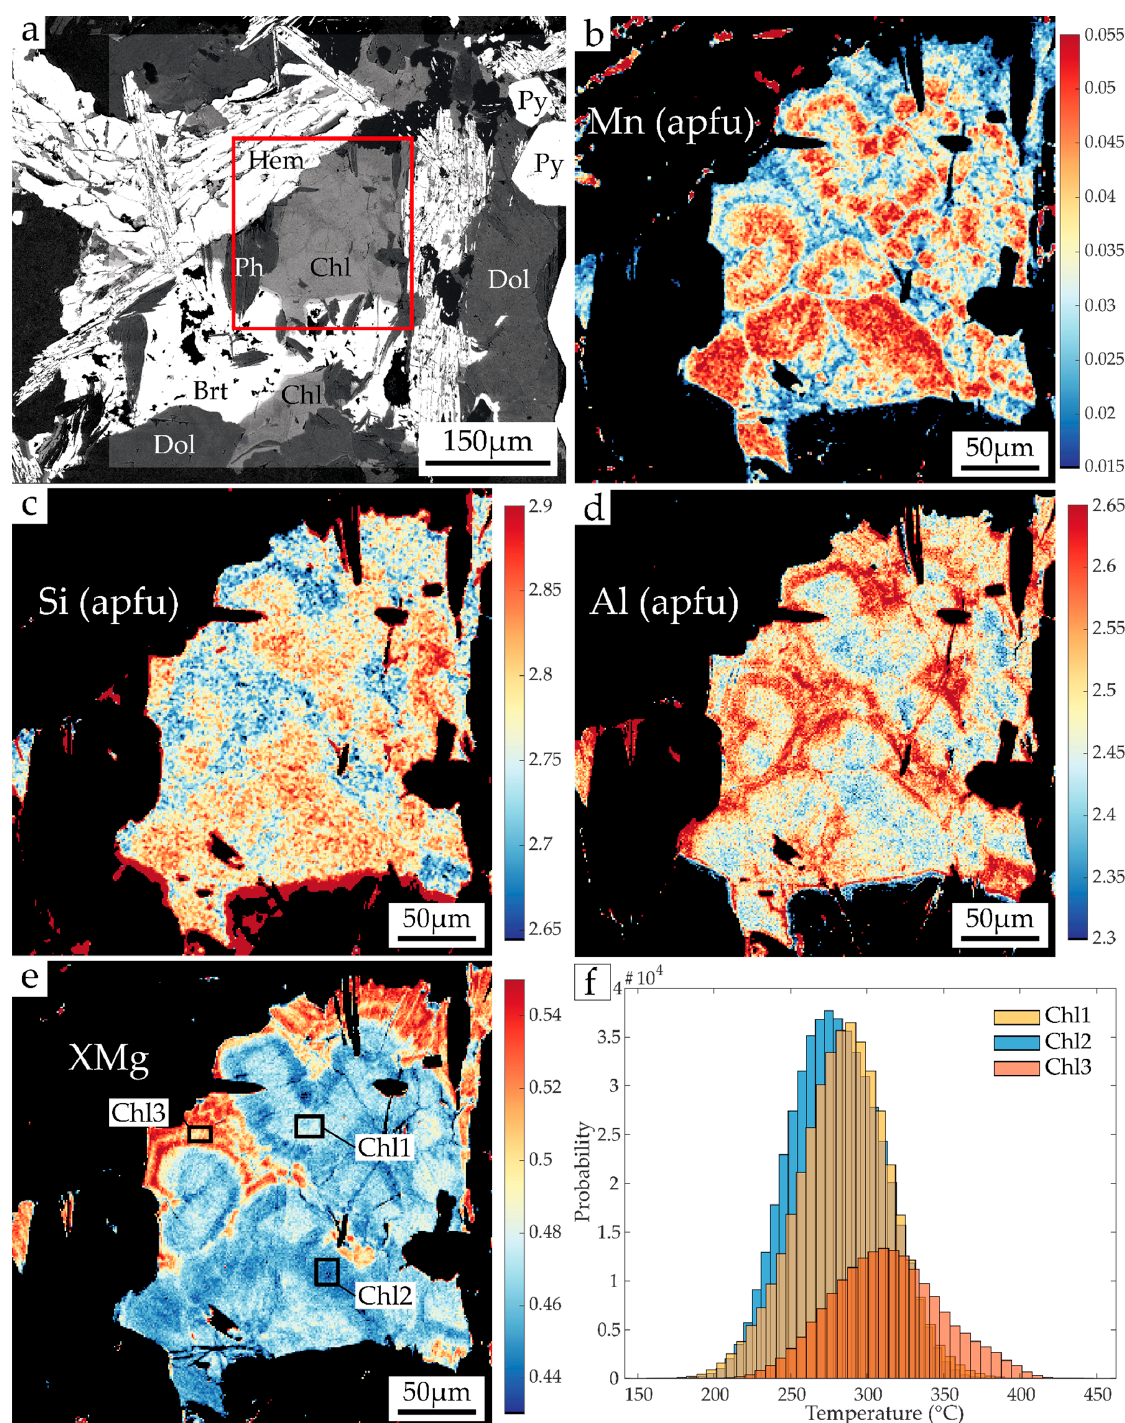
Figure 8. ( a ) Backscatter (BSE) electron image of euhedral rosette-shape chlorite aggregates with chemical zoning. The red frame displays the zone of the X-ray map. Quantified X-ray chlorite maps (in apfu) of: ( b ) Mn; ( c ) Si; ( d ) Al; ( e ) XMg content (XMg = Mg/(Mg + Fe tot )) with black boxes showing the pixel zone analyzed of each representative chlorite zone, as discussed in the text. ( f ) Histogram of chlorite temperature formation calculated on each pixel from the map.